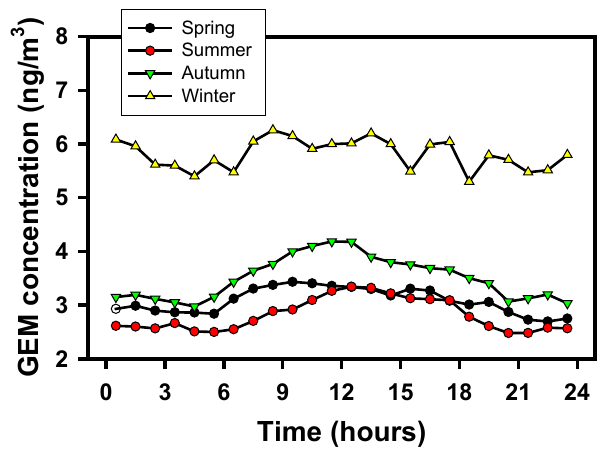
Fig. 3. Seasonal changes in diel GEM cycle over the northern SCS based on seasonal average concentrations for each hour. Each sea- son is the average of diel data from 3